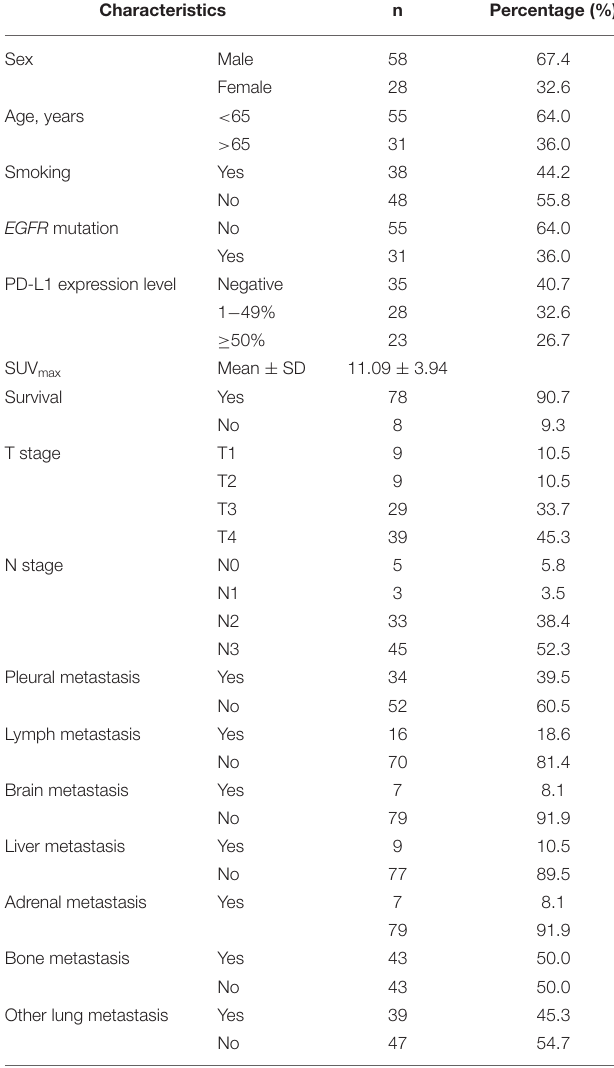
FIGURE 2 | Identification of PD-L1–positive tumor cells: (A) Negative staining (TPS < 1%). (B) Weakly positive staining (TPS 1–49%). (C) Highly positive staining (TPS ≥ 50%). PD-L1, programmed death-ligand 1; TPS, tumor proportion score. TABLE 1 | General patient characteristics ( n =